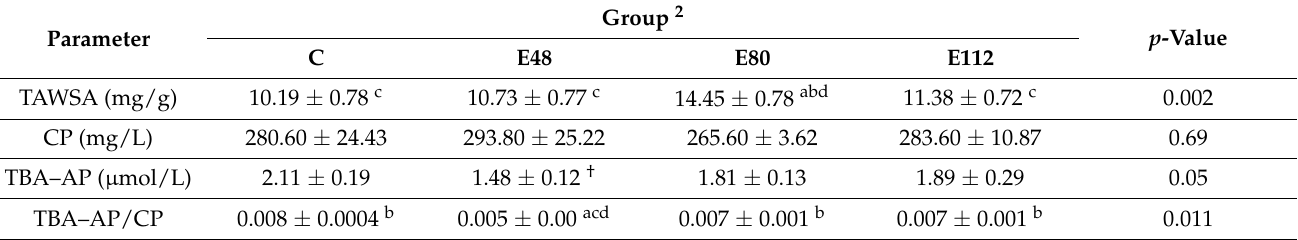
Table 7. Antioxidant blood parameters at the end of the experiment (d98) 1